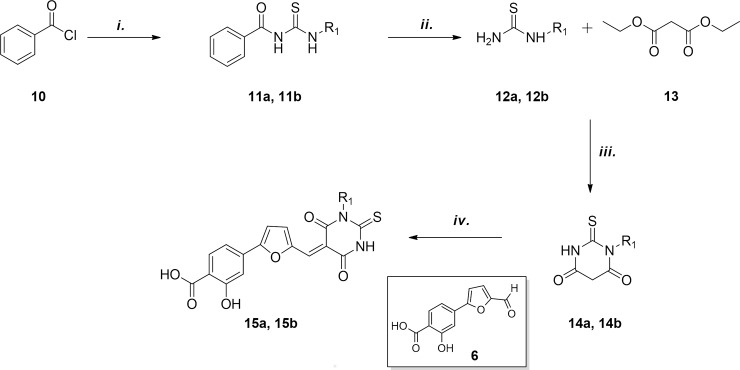
Synthesis of monosubstituted thiobarbituric compounds 15a and 15b: i. a) NH4SCN, (CH3)2CO, 60°C MW, min, b) opportune amine (CH3)2CO, 60°C MW, ii. NH2NH2; iii. Na0, EtOH, reflux, iv. HCl, EtOH, 70°C.